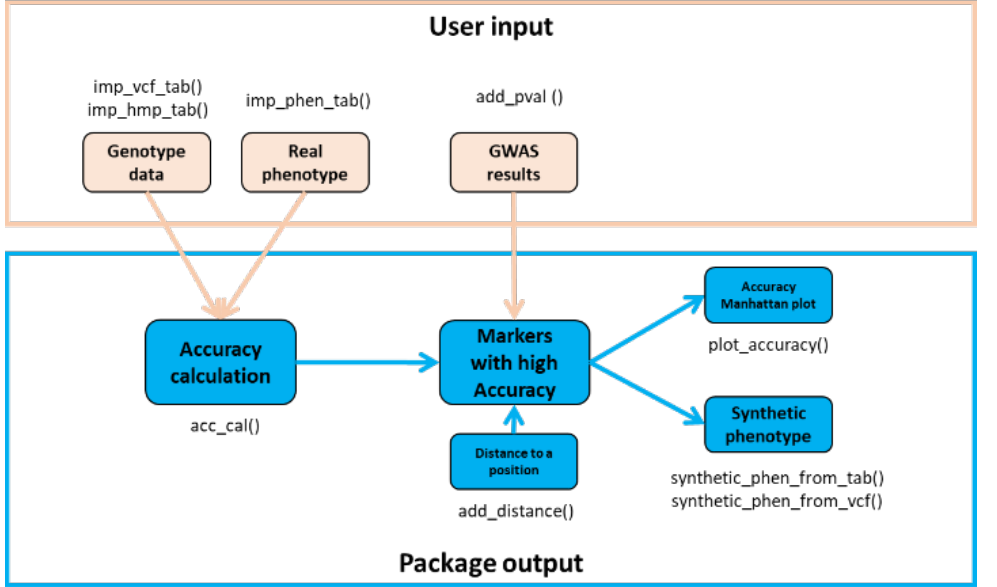
Figure 2. The AccuCalc workflow. Inputs (orange), outputs (blue), and AccuCalc follow the same logic as published in our former work